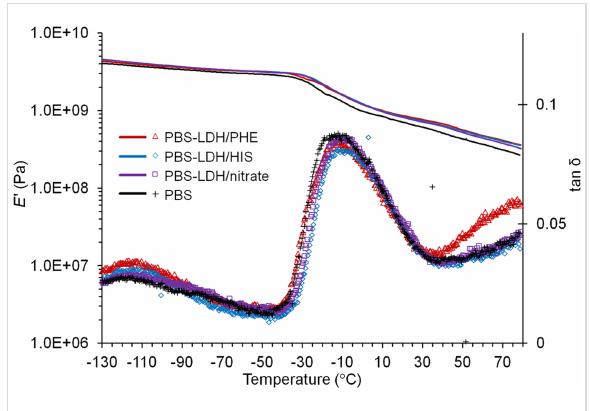
Figure 8: E ’ and tan δ as a function of temperature for PBS and PBS nanocomposites with Mg 2 Al LDHs.